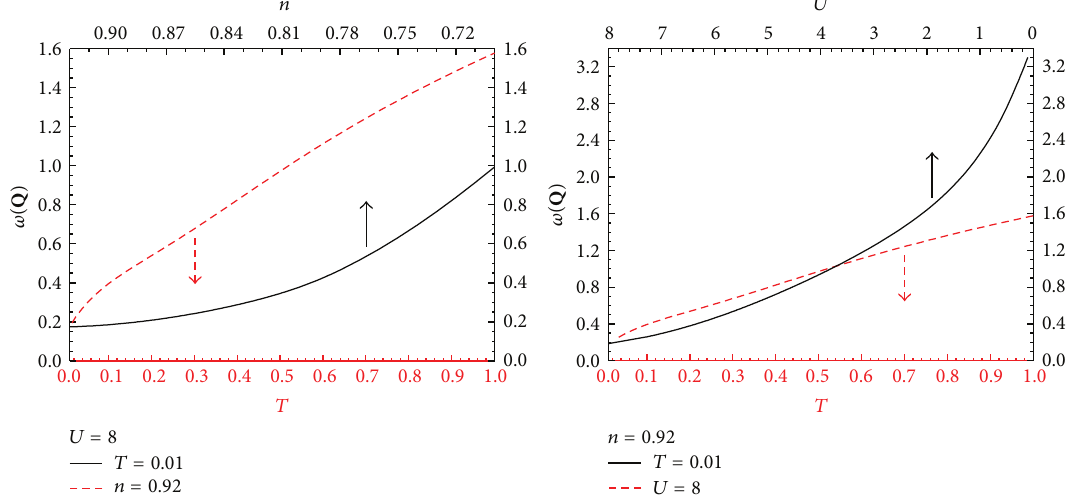
Figure13:(Coloronline)Thepole 𝜔 (3) ( Q ) ofthespin-spinpropagatorasafunctionoffilling 𝑛 ,temperature 𝑇 ,andon-siteCoulombrepulsion 𝑈 in the ranges 0.7 < 𝑛 < 0.92 , 0.01 < 𝑇 < 1 , and 0.1 < 𝑈 < 8